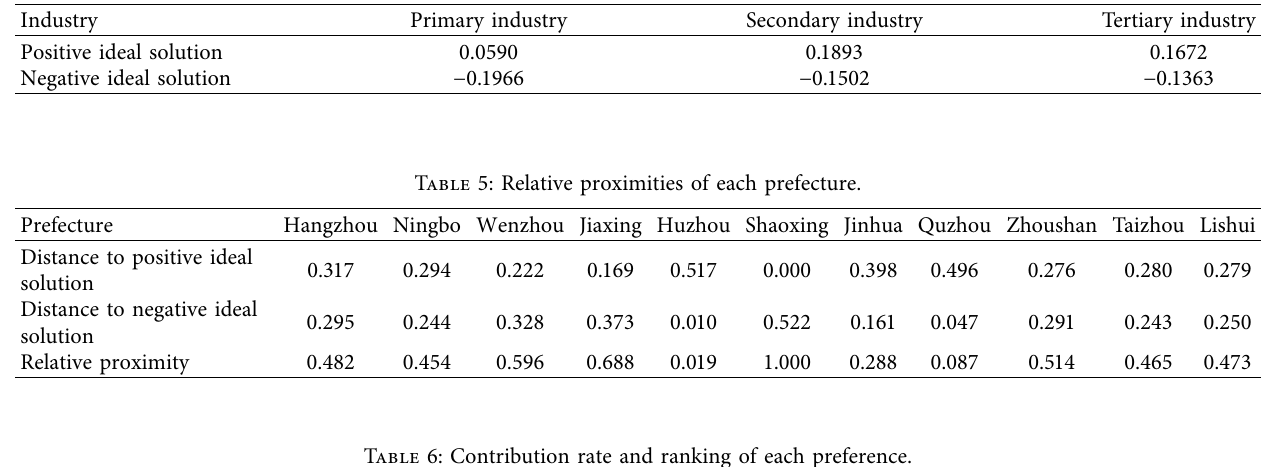
Table 4: Positive and negative ideal solutions.